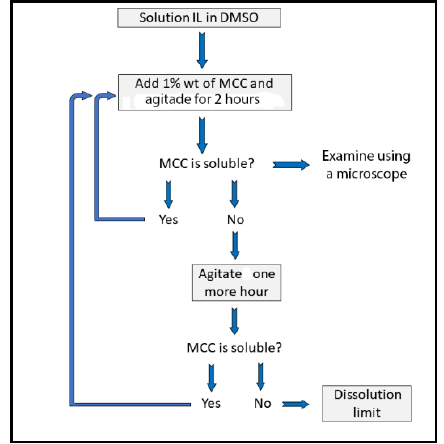
Figure 3. Flow chart for the steps of the cellulose dissolution experiment. Microcrystalline cellulose, (MCC); dimethyl sulfoxide, (DMSO).